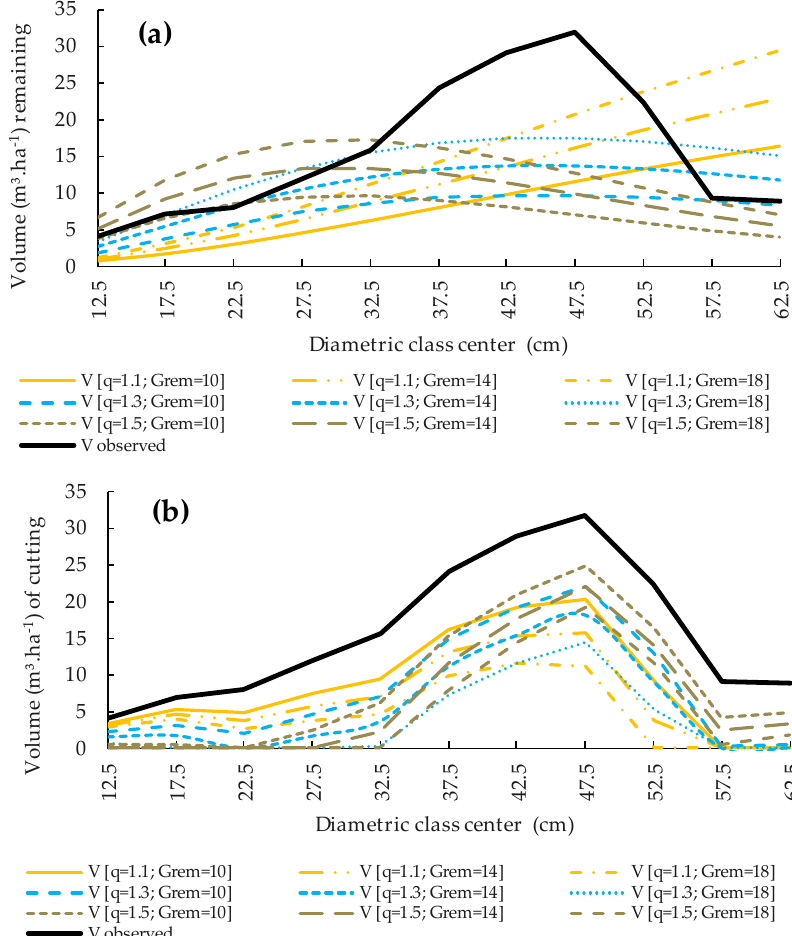
Figure 3. Remaining volume and cutting behavior per hectare for different scenarios, with varying Liocourt’s quotient (q = 1.1, 1.3, 1.5) ( a ) and remaining basal area (Grem = 10.0, 14.0, 18.0) ( b ) for A. angustifolia (Bertol.) Kuntze in the Araucaria Forest in Lages, SC.